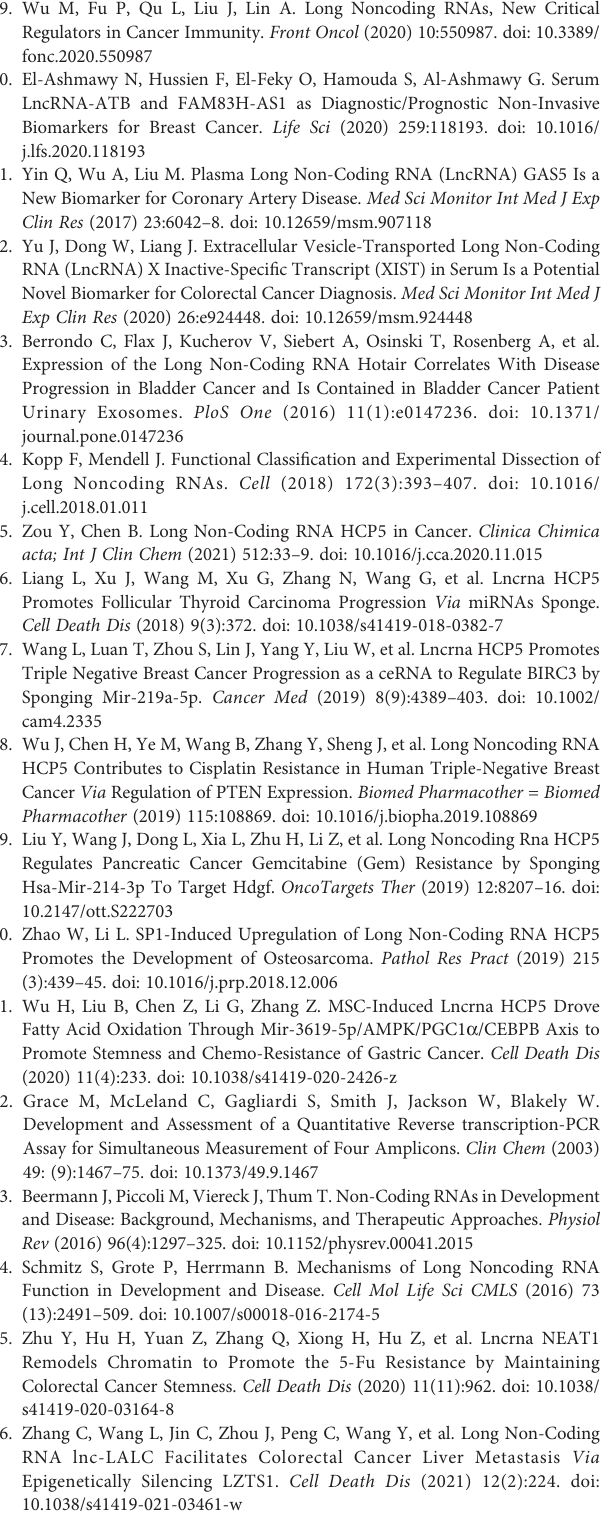
Supplementary Figure 3 | The time-dependent studies on HGC-27, BGC-823, and GES-1 cells.